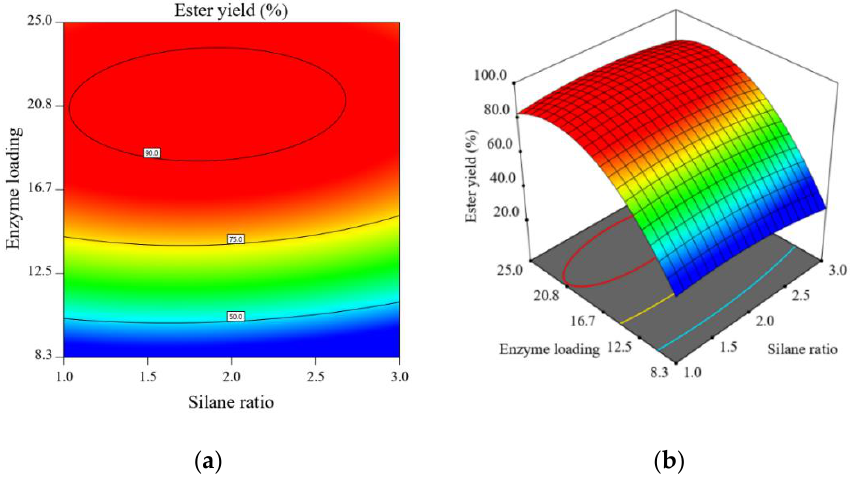
Figure 3. Contour ( a ) and 3D surface ( b ) plots of the system response (ester yield) in the enzymatic synthesis of n -amyl caproate, catalyzed by sol-gel-entrapped lipase from Candida antarctica B for different values of factors A (TMOS:GPTMS silane ratio) and B (enzyme loading).